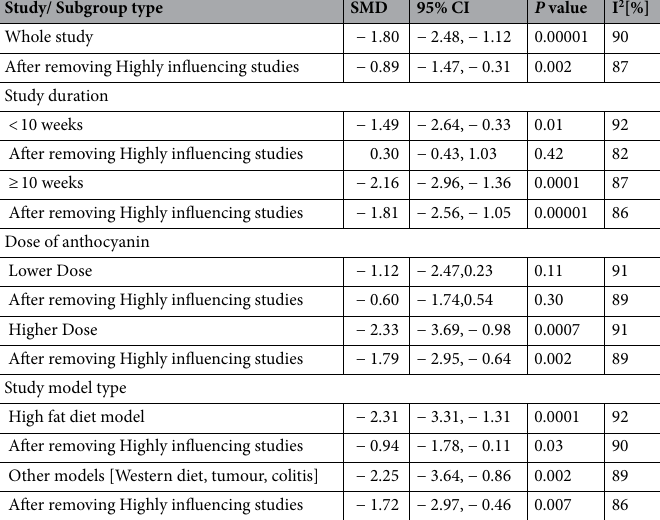
Table 3. All-inclusive, high-influencer subtracted and sub-group [intervention duration, dose, and animal model type] analysis to understand the effects of anthocyanins on the Fir/Bac ratio. Pooled effect sizes and 95% CI were determined using random effects model. SMD Standardised mean difference, I 2